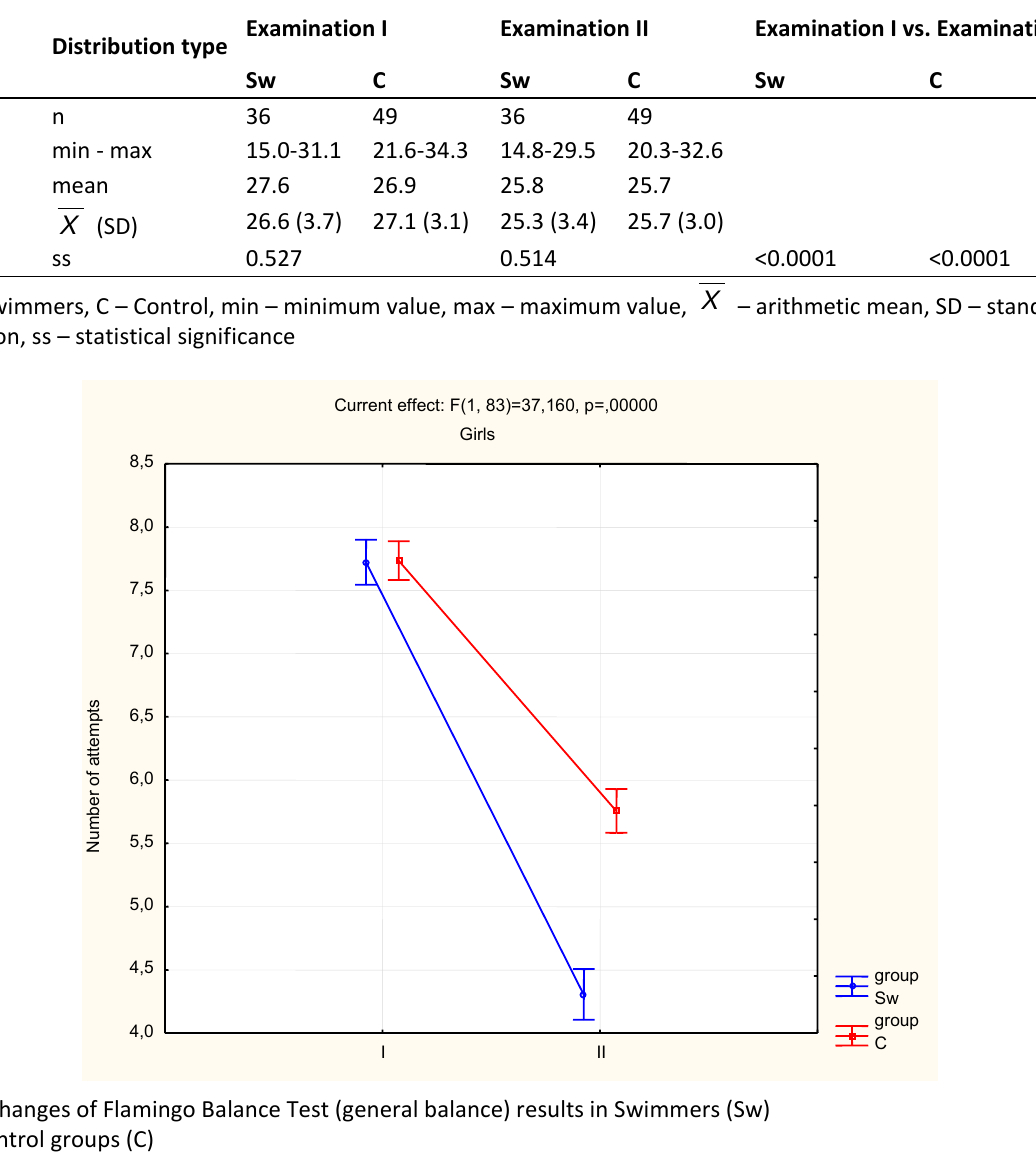
Table 3. Descriptive characteristics of Plate Tapping Test (speed of upper limb movements) results in the Swimmers Group (Sw) and Control group (C).